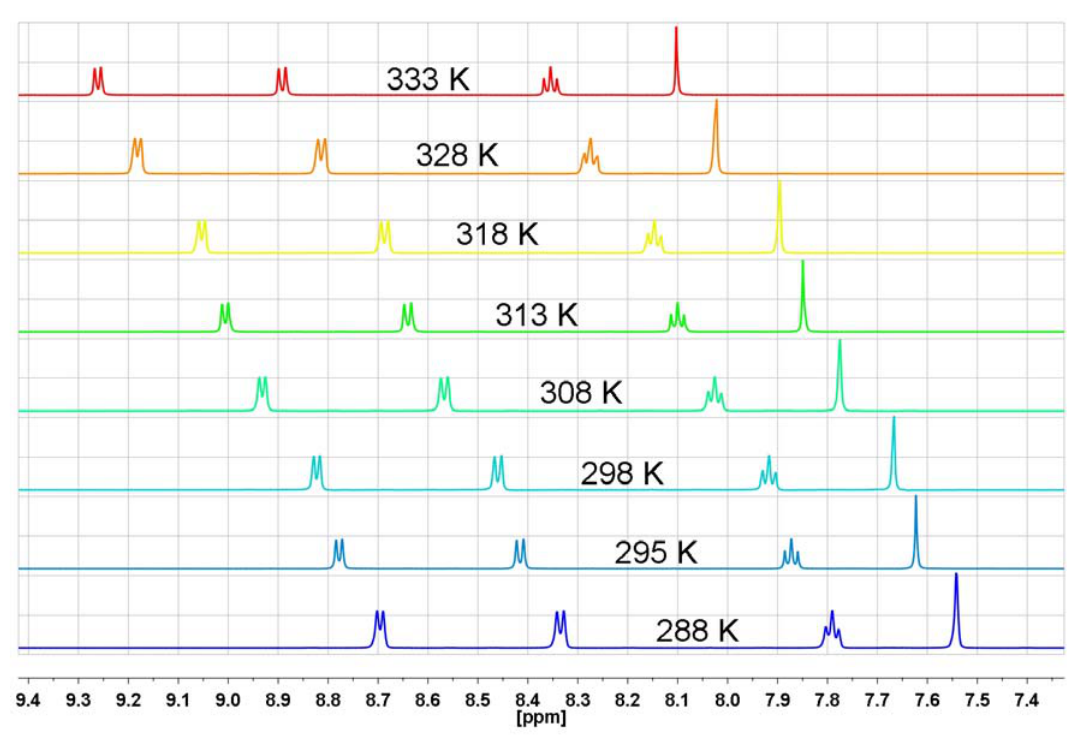
Figure 16. The aromatic protons region of the 1 H-NMR spectrum in TFA-d